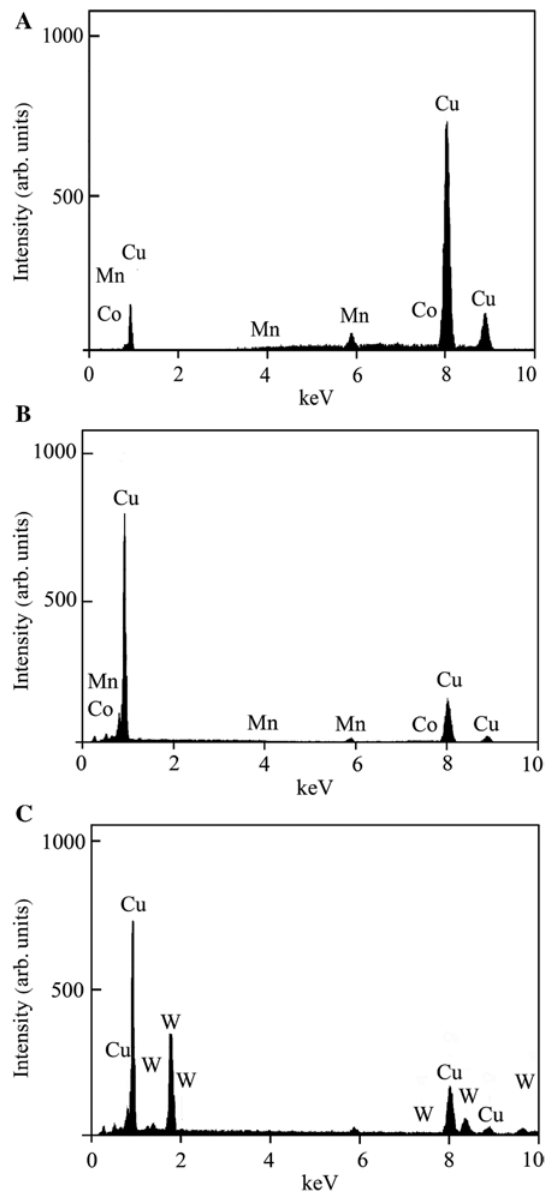
Figure 10: EDS results of the different morphologies on the fracture surface: (A) point a; (B) point b; (C) area